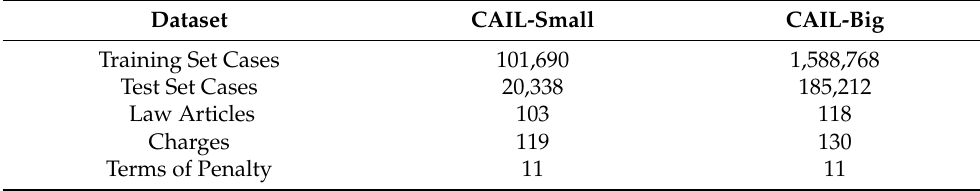
Table 1. Dataset